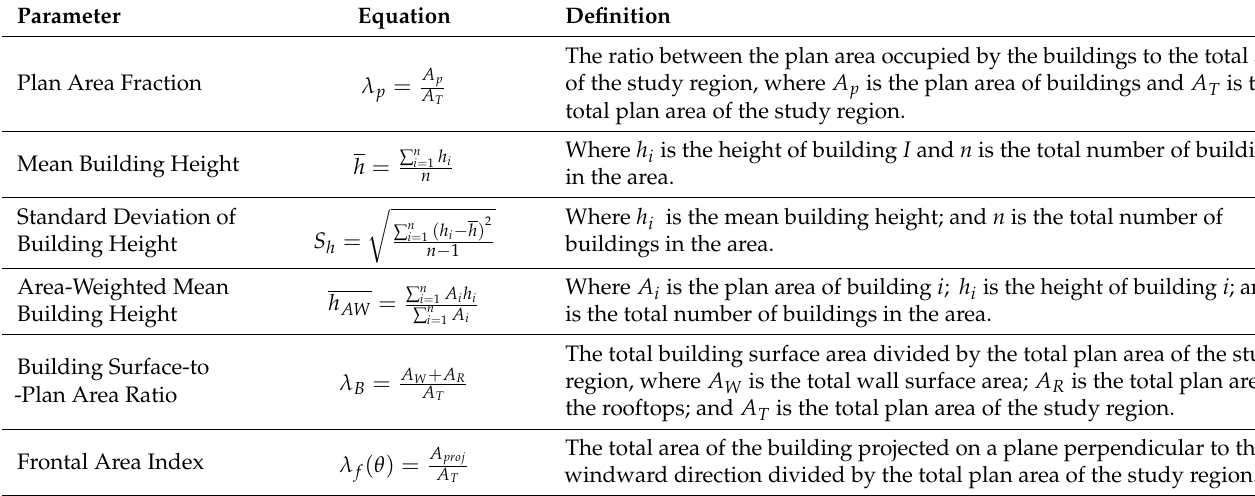
Table 2. Local refined urban morphology parameters of different urban canopy schemes in the WRF